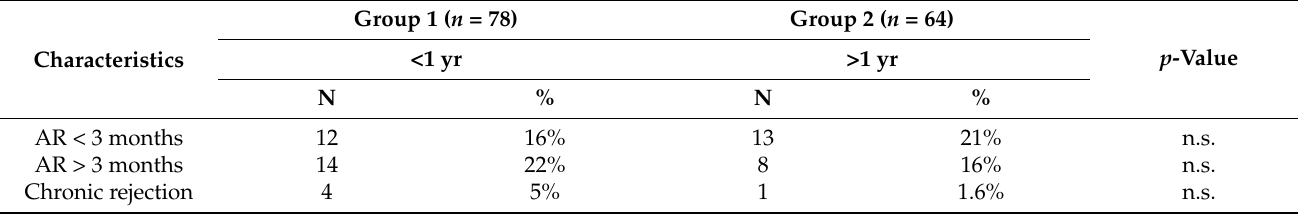
Abbreviations Table 3: yr—year, AR—acute rejection, n.s.—not significant.